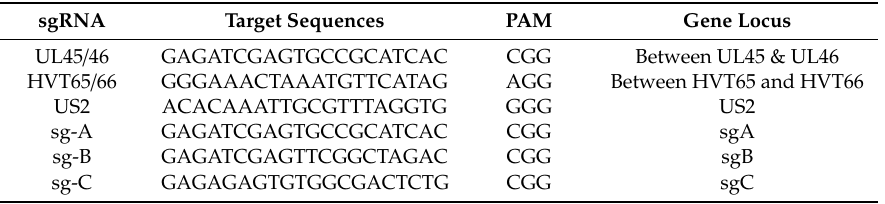
Table 1. sgRNA targeting sequences in HVT * genome and donor constructs.